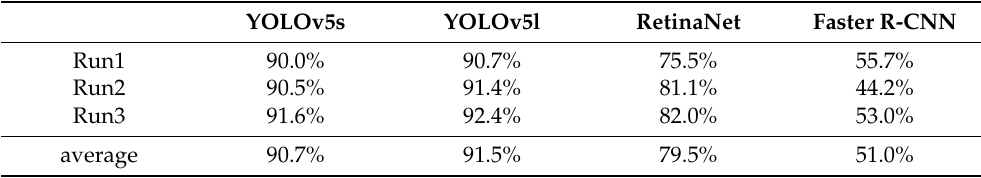
Table 4. Comparison of selected YOLOv5, RetinaNet, and Faster R-CNN mAP@.5:.95 values of detection of pollen grains in the testAll